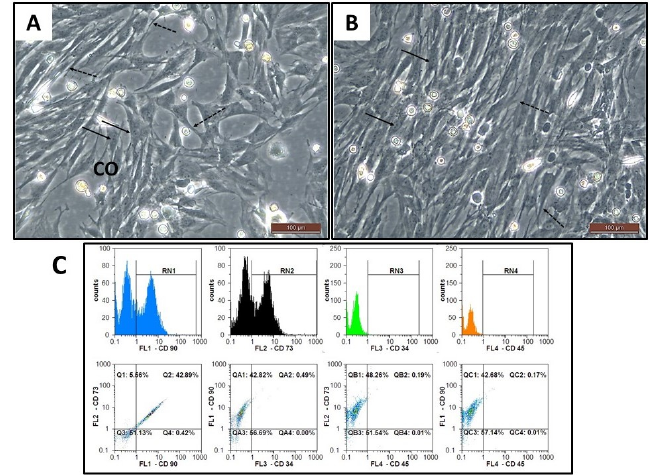
Figure 1. Phase-contrast photomicrographs of the isolated BM-MSCs during P0 ( A ) and P2 ( B ). The cells showed heterogeneous morphology during P0 and homogeneous fibroblast-like morphology during P2. Colonies (CO) were evident. The cells displayed granular cytoplasm with large nuclei having multiple nucleoli (Arrow) and many cytoplasmic processes (dashed arrow). ( C ): flow cytometric analysis of stem-cell marker expression on the culture MSCs during P2.